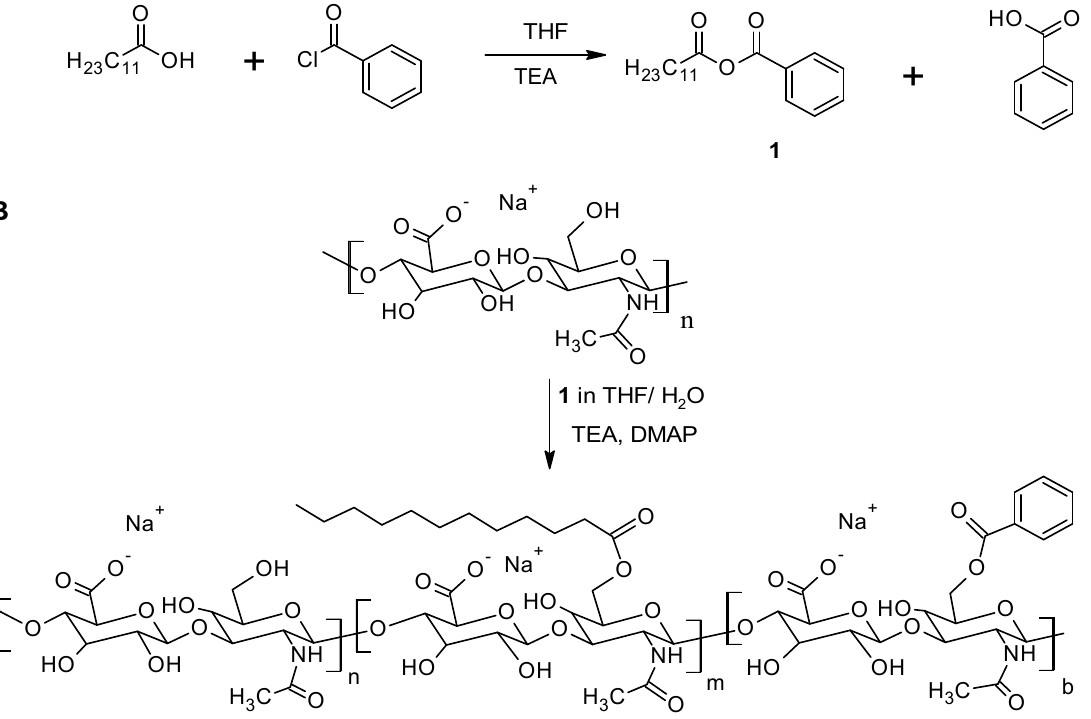
Figure 1. ( A ) The activation of dodecanoic acid mediated by benzoyl chloride. ( B ) The esterification of medium molecular weight HA carried out in water/THF.